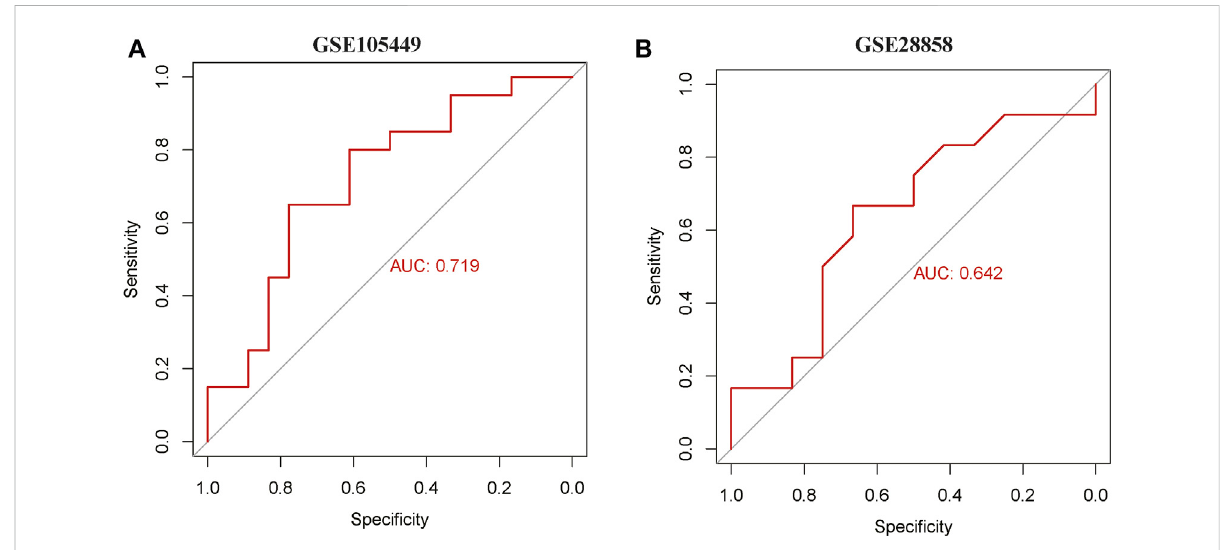
FIGURE 6 ROC curve analysis. (A) ROC curve of GSE105449. (B) ROC curve of